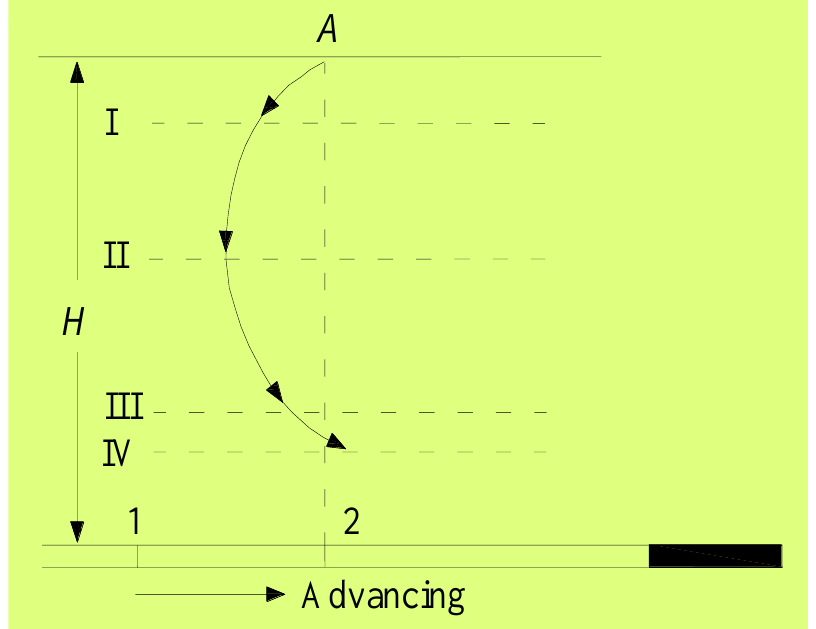
Figure 1. Schematic diagram showing the dynamic change of a surface point in the main section as the working face advances.